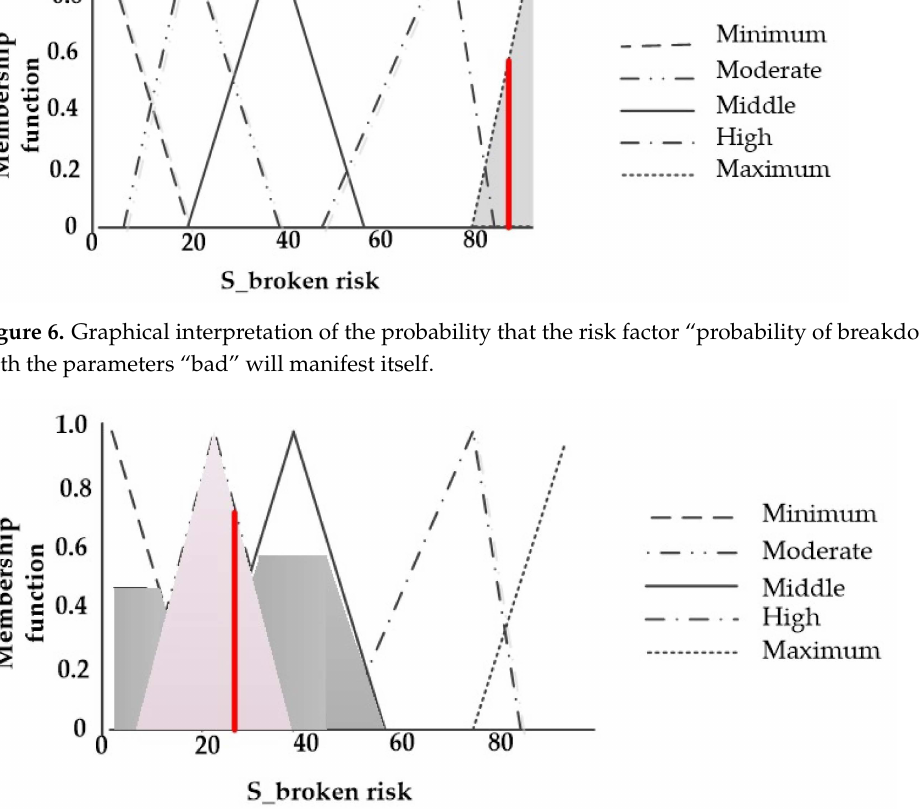
Figure 7. Graphical interpretation of the probability that the risk factor “probability of breakdown” with the parameters “excellent” will manifest